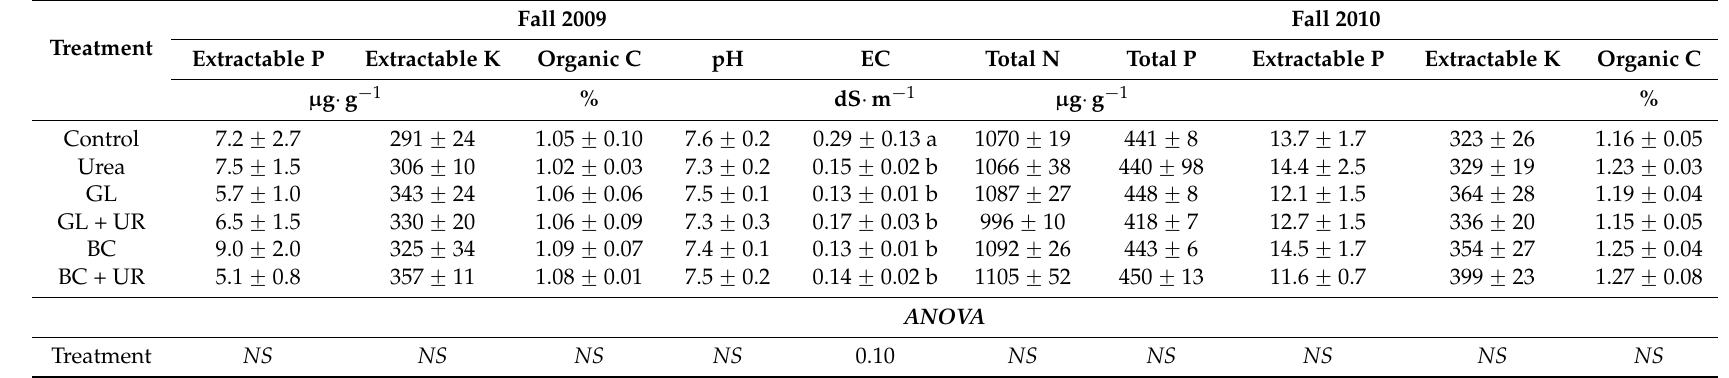
Means within a column sharing the same letter are not significantly different at p =